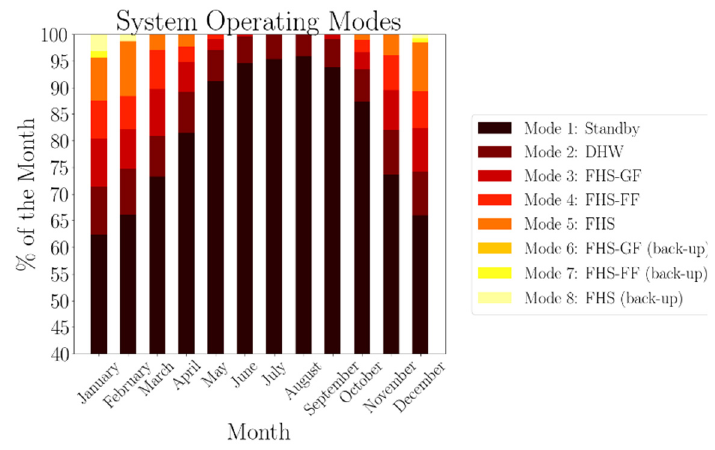
Figure 12. Monthly distribution of the system’s operating modes. FHS: Floor heating system, GF: ground floor and FF: first floor.